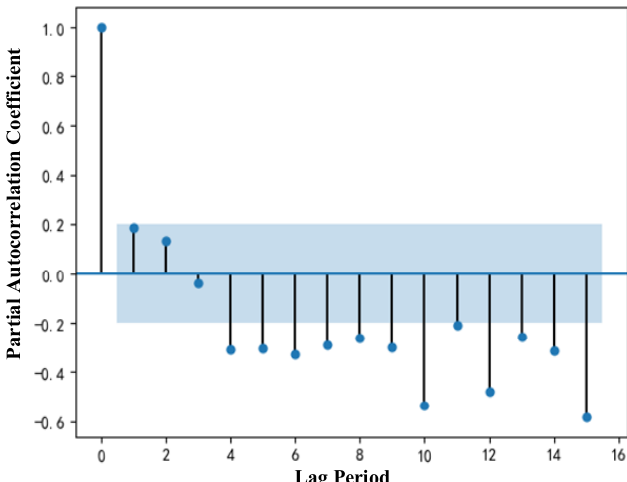
Figure 13. Offset distance PACF analysis.